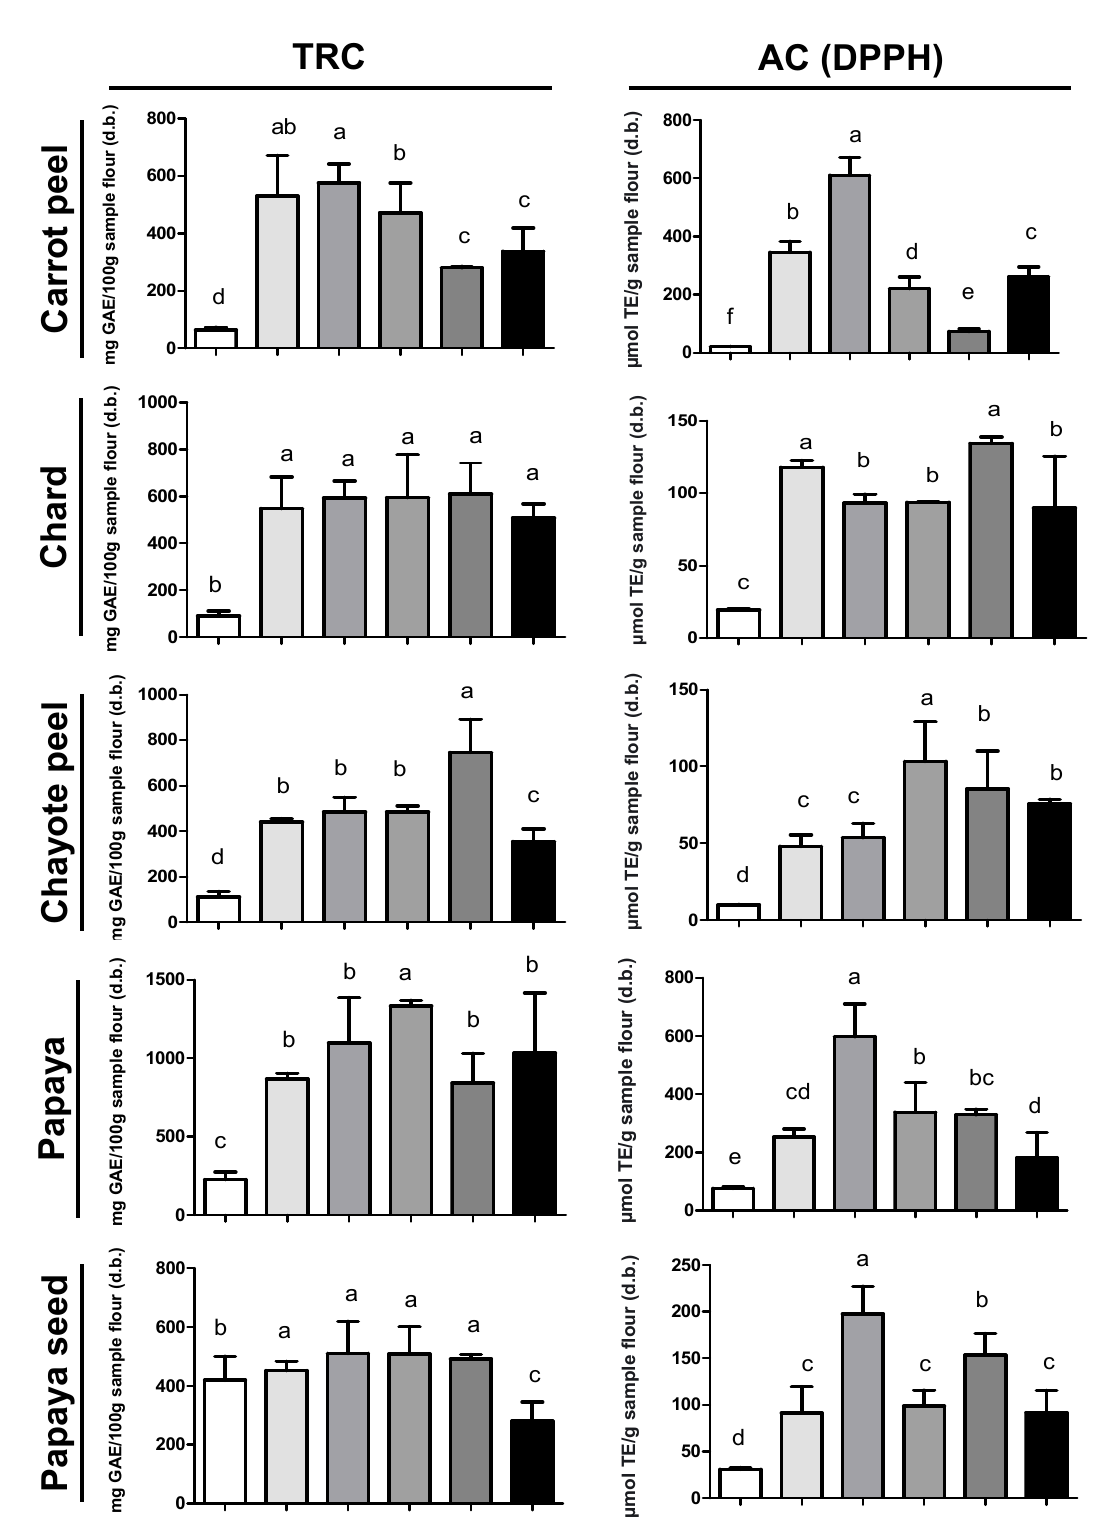
Figure 1. Evaluation of total reducing capacity (TRC) and antioxidant capacity (AC) by the DPPH method using six different extractors on five fruit and vegetable by-products (FVB). Results are expressed as mean ± standard deviation ( n = 3). Different letters indicate a significant difference between extractors (Tukey, p < 0.05).